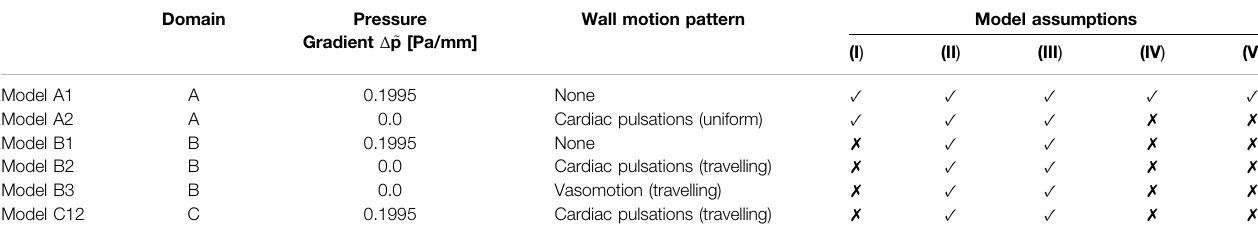
TABLE 2 | Overview of computational models parameterized by domain, prescribed pressure gradient Δ ~ p and wall motion pattern (see Methods).